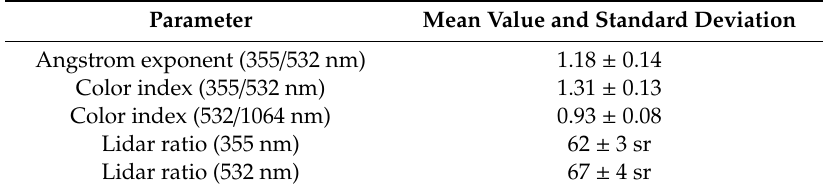
Table 4. Mean values of the intensive optical parameters over Europe between 2008 and 2018 as retrieved from EARLINET lidar measurements (808 layers that passed the QA